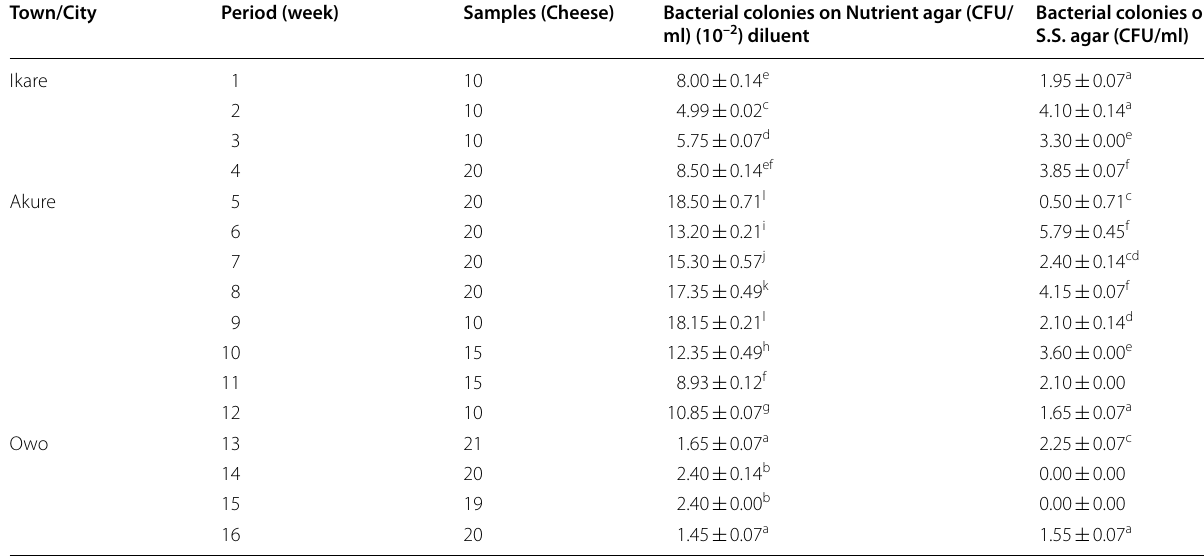
Data are presented as mean shigella; CFU—Colony forming unit